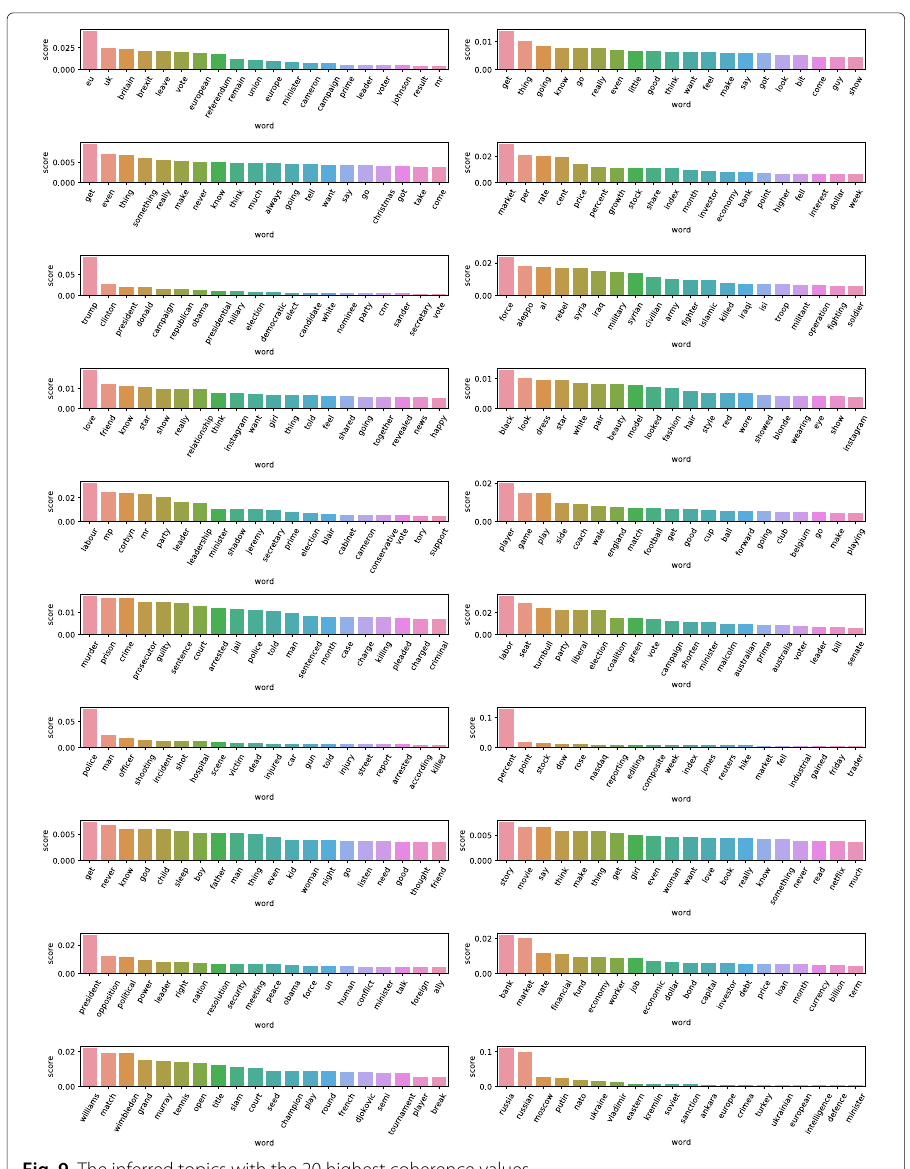
Fig. 9 The inferred topics with the 20 highest coherence values